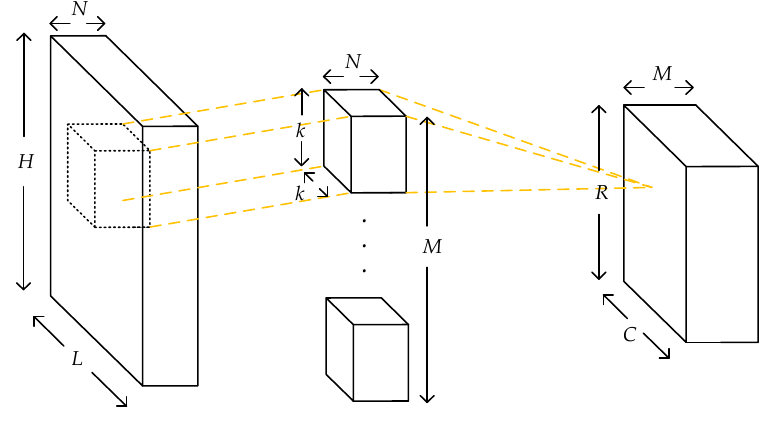
Figure 1. Convolution operation.